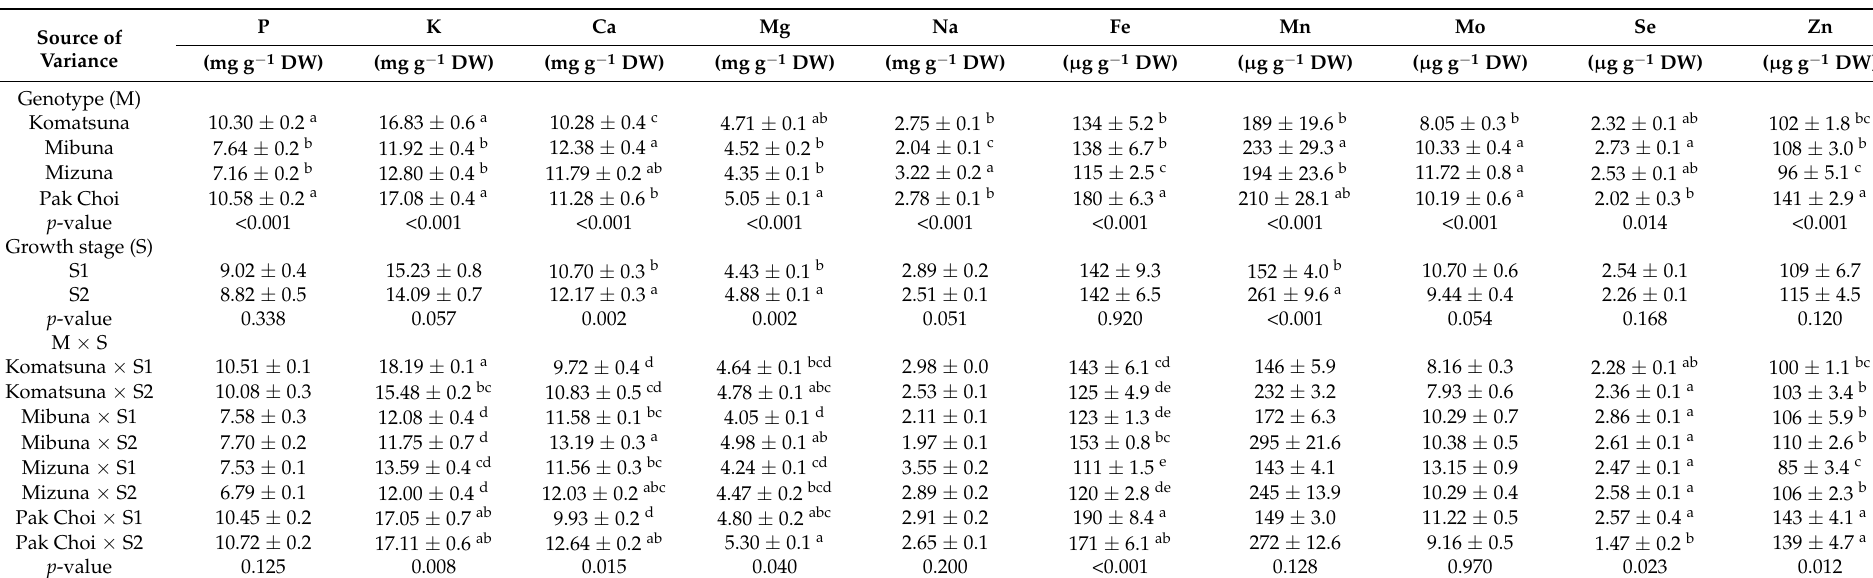
Table 2. Mineral content of four Brassica rapa L. microgreens genotypes harvested at the first (S1) or second true-leaf stage (S2). All data are expressed as mean ± standard error, n = 3. All data are expressed as mean ± standard error, n =